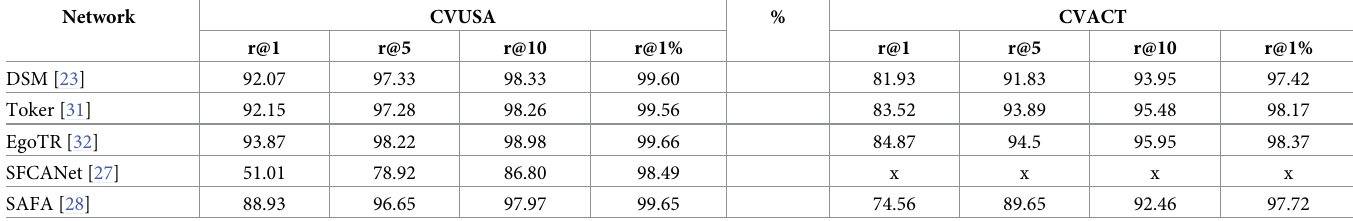
Table 4. The r@ k metrics for the networks used to construct the ensemble model.